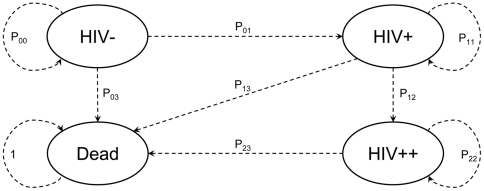
State transition diagram of the Markov chain.Ellipses define the four different health states of the model (HIV−, HIV+, HIV++ and Death). The dashed arrows represent the probabilities of going from one state to another in the subsequent period.